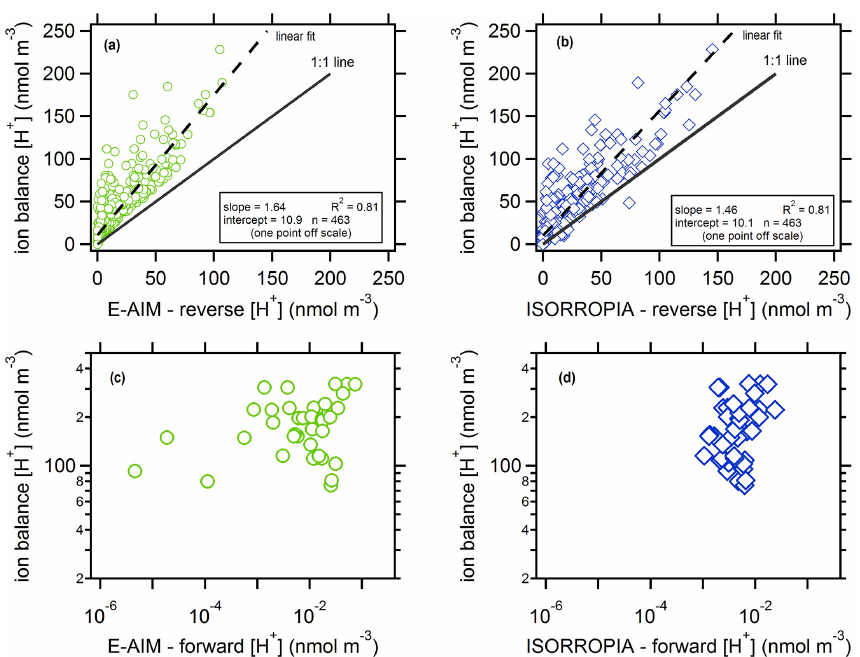
Figure 7. H + levels inferred from the ion balance compared to H + levels predicted by (a) E-AIM in the reverse mode, (b) ISORROPIA in the reverse mode, (c) E-AIM in the forward mode, and (d) ISORROPIA in the forward mode. Note the different log scales for the x and y axes in (c) and (d) .